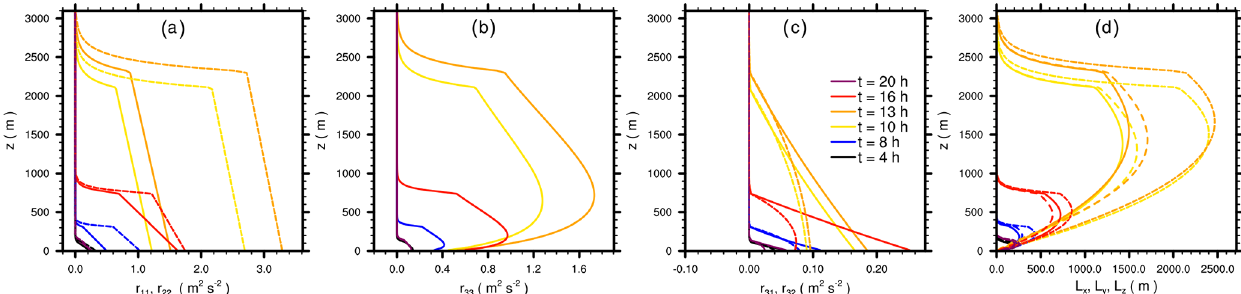
Figure 13. Parameterized components of the Reynolds-stress tensor as well as turbulent length scales at different points in time. In panels (a) and (c) , the solid (dashed) line belongs to r 11 ( r 22 ) and r 31 ( r 32 ), respectively. In panel (d) the solid, fine, and coarse dashed lines belong to L x , L y , and L z ,